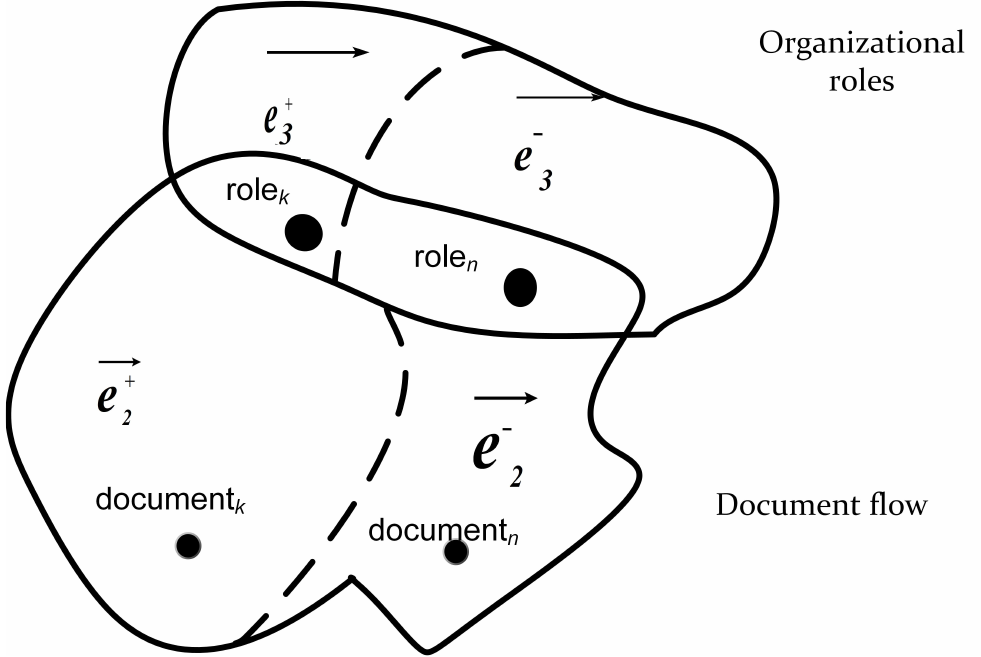
Figure 3. An example of s Directed Hyper-graph.